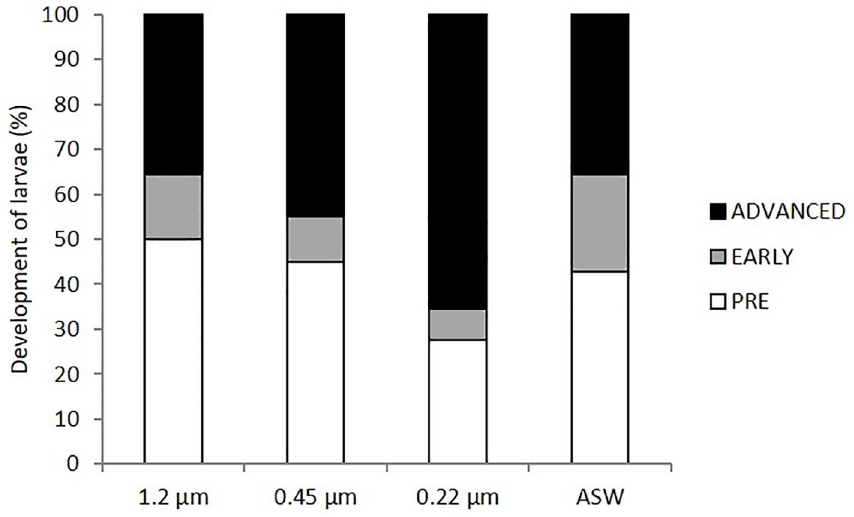
Fig 3. Development of Rhytisma fulvum fulvum planulae on day 32 of incubation. Planulae were maintained with different levels of filtered seawater (FSW) and autoclaved seawater (ASW) with water change on alternative days. Results correspond to the same experiment shown in Fig 1. Planulae development was classified into three stages: pre- metamorphosed (open bars); early metamorphosis (grey bars); and advanced metamorphosed (dark bars). Cultures were maintained under light:dark cycle (12:12 hours). The advanced metamorphosis stage corresponds to the Advanced-short plus Advanced-long stages described in Materials and Methods. Percentages were calculated on the basis of the analysis of all survived